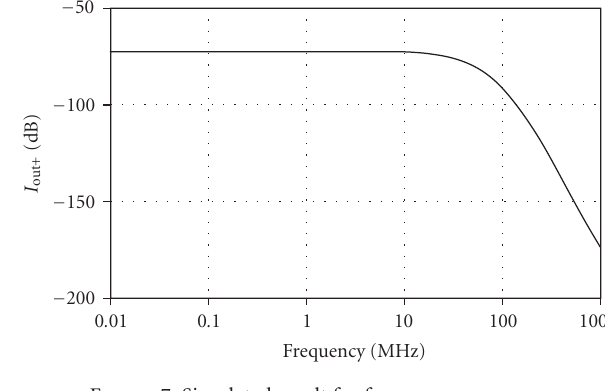
Figure 7: Simulated result for frequency responses.